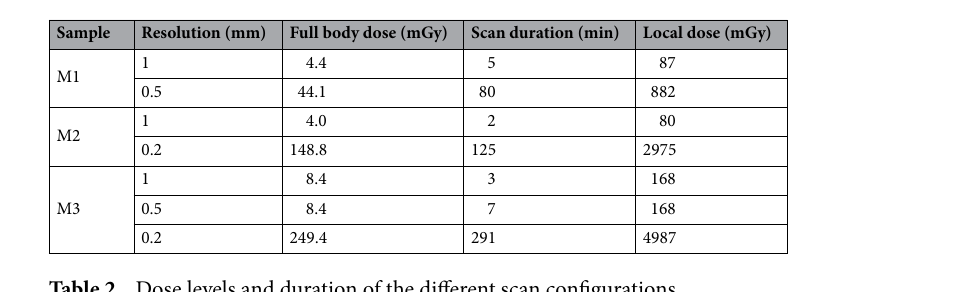
Table 2. Dose levels and duration of the different scan